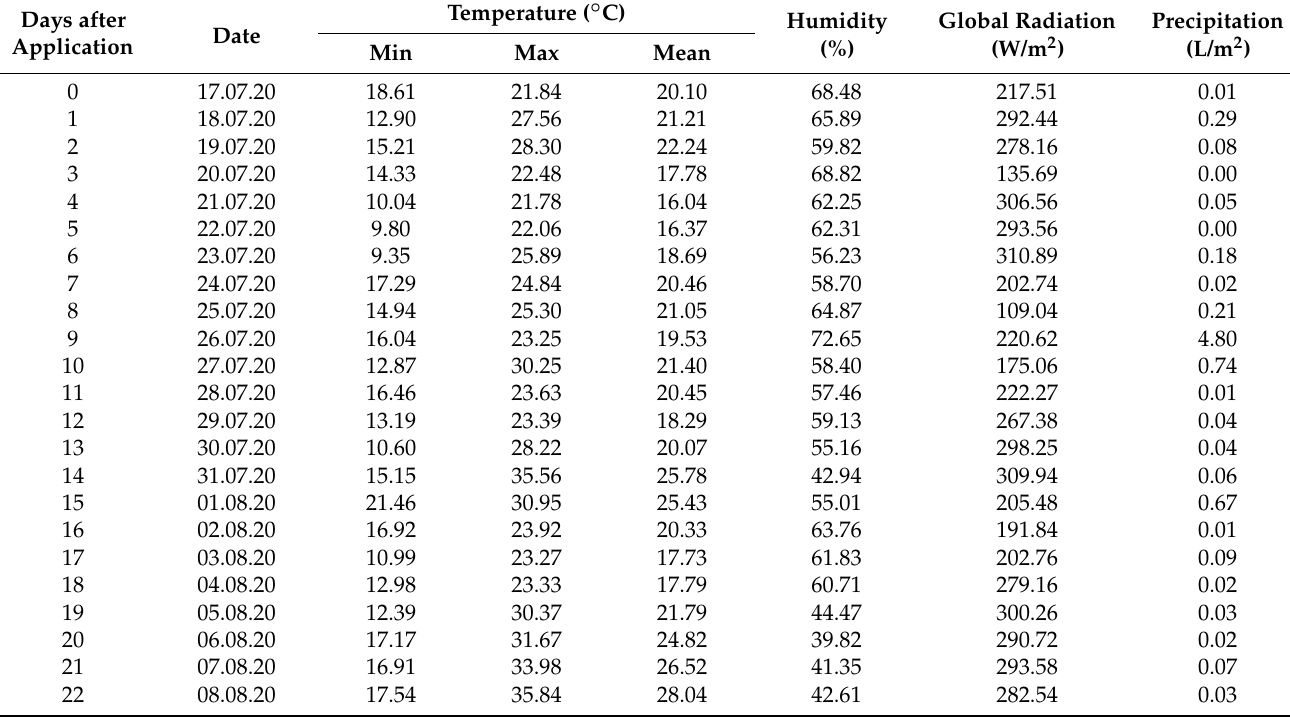
Table A1. Meteorological data for the study site and study period (12:00, 17 July